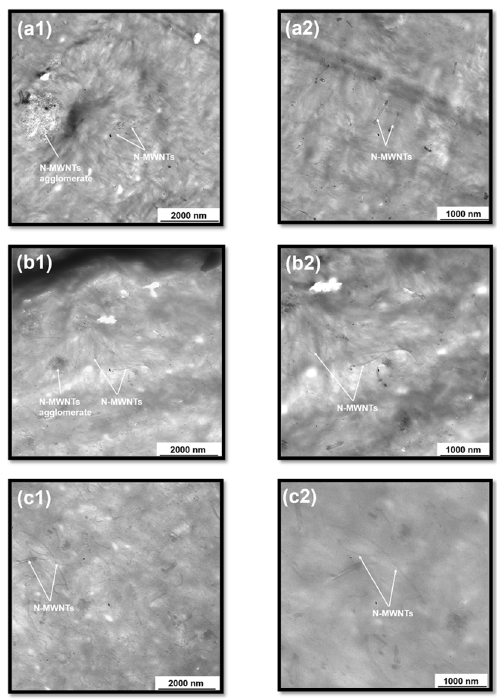
Figure 7. TEM micrographs of PVDF nanocomposites containing 2 wt.% N-MWNTs synthesized with Fe catalyst of ( a1 , a2 ) 10 wt.%, ( b1 , b2 ) 20 wt.%, and ( c1 , c2 ) 40 wt.%.